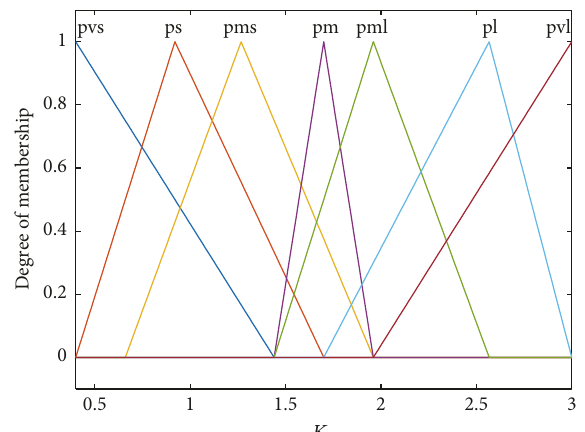
Figure 7: Membership functions designed for the output 𝑘 𝑑 .